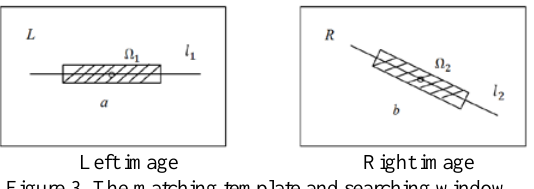
Figure 3. The matching template and searching window According to figure 3 the shelter area and